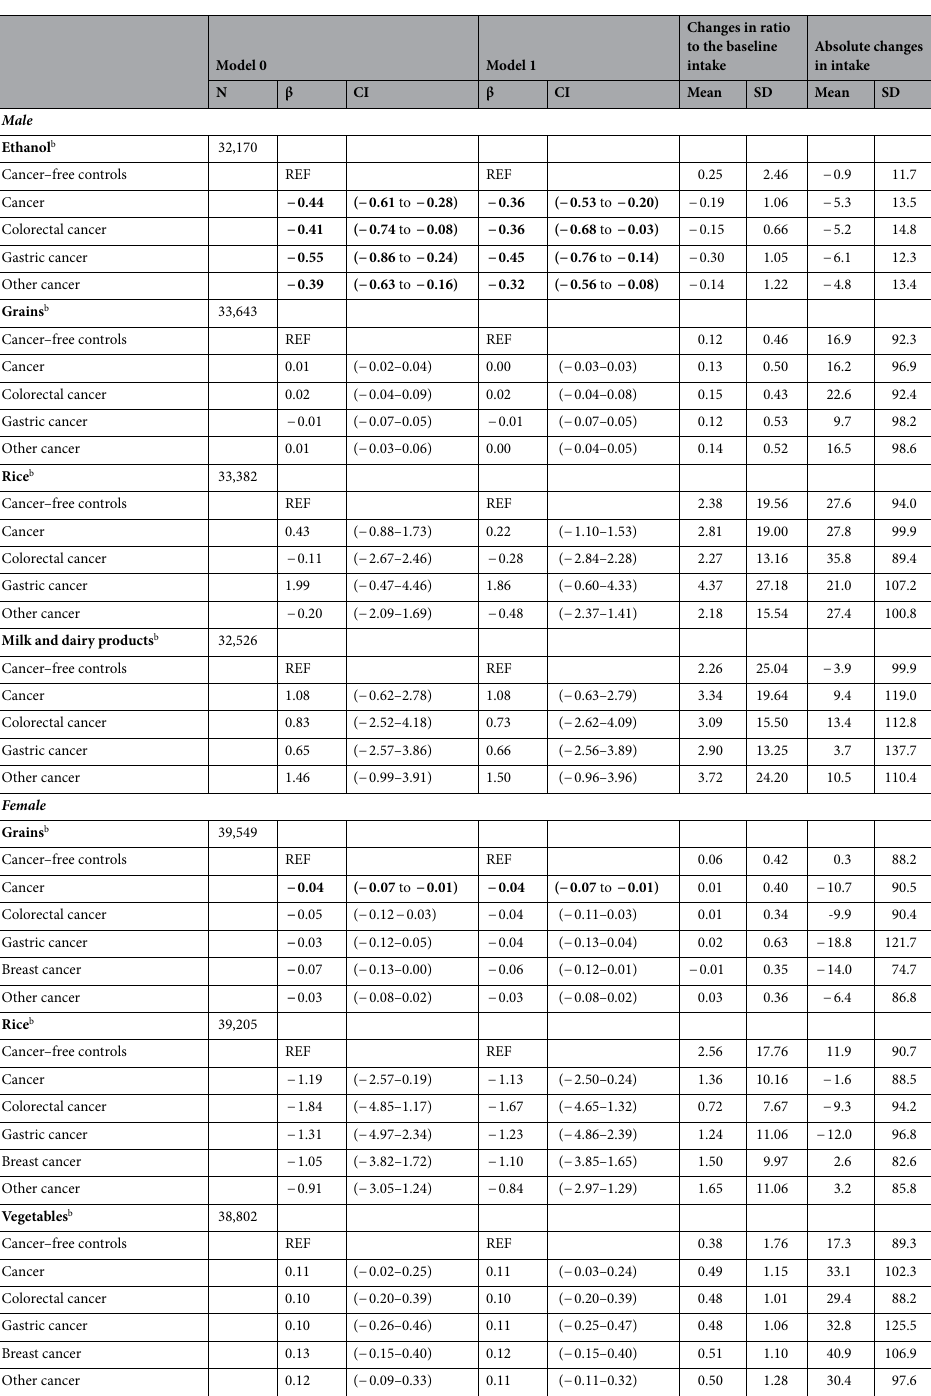
Table 4. Relative changes a in energy-adjusted nutrient and food group intakes in cancer survivors compared with controls for male (n = 33,643) and female (n = 39,549). β: Difference in the intake changes compared with cancer–free controls, CI: 95% confidence intervals. a Changes are expressed as the ratio to the baseline